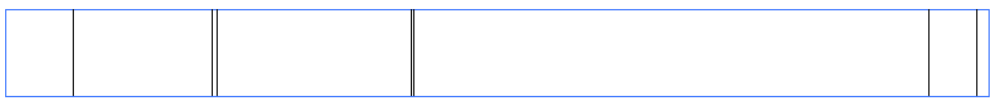
Fig. 2. The frequency of use of the concept of ‘event’ (source No. 17) (Developed by the author using AntConc )